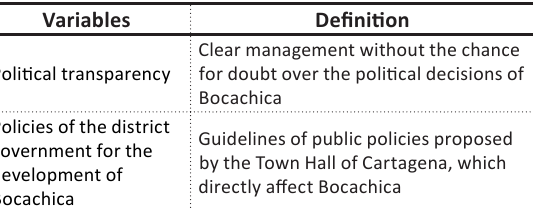
Source: Elaborated by the authors.